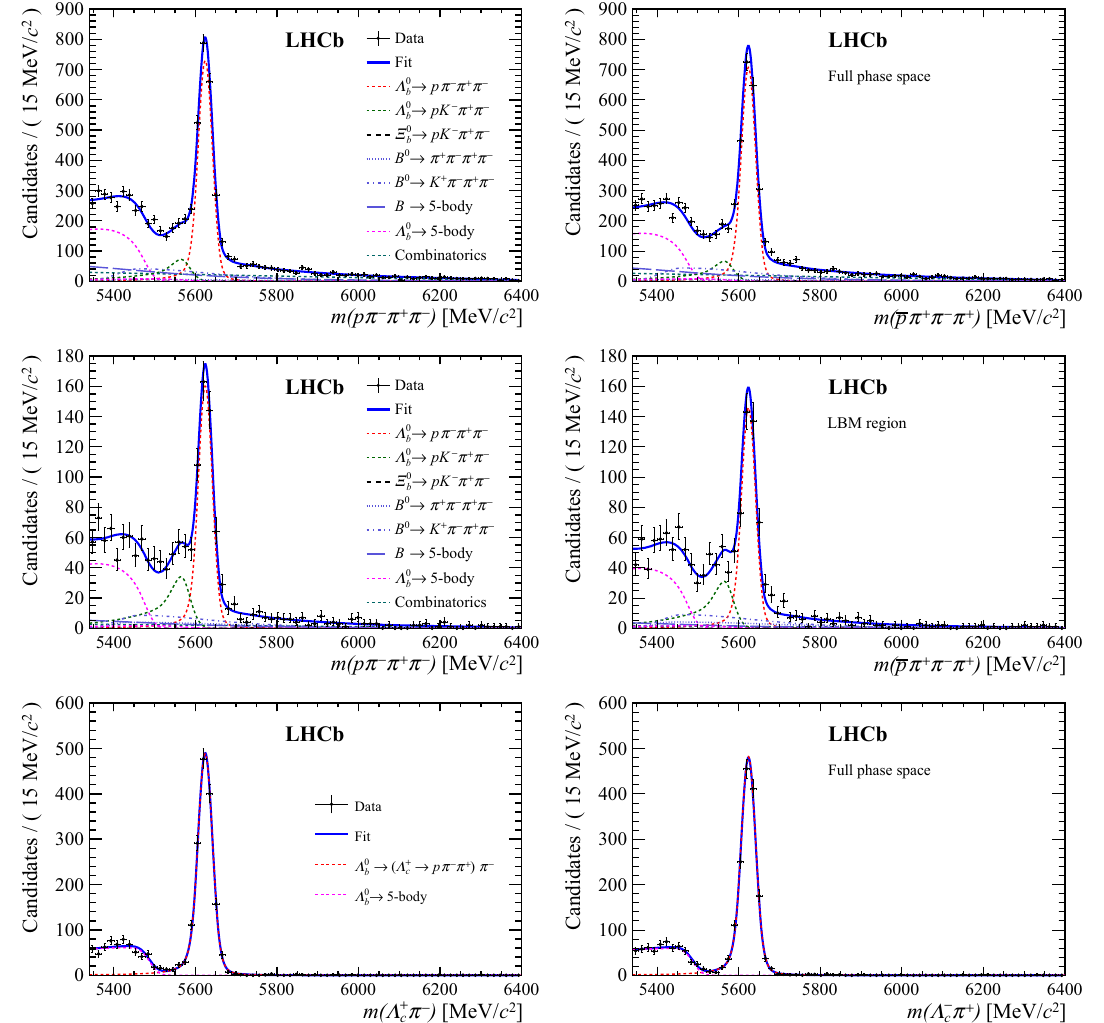
→ five-body legend b → p π − η (cid:4) b